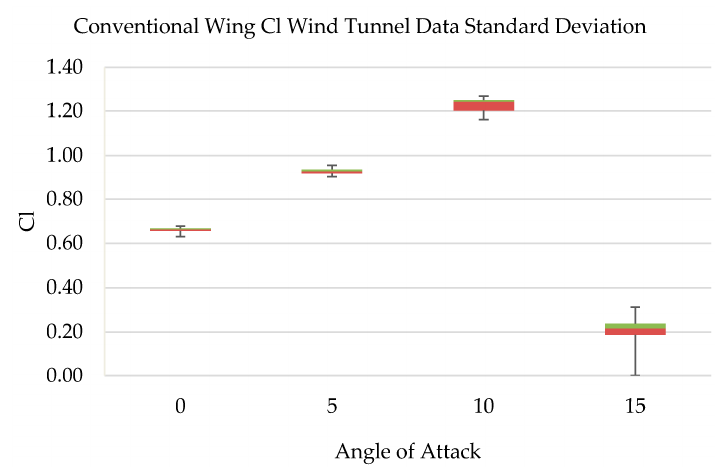
Figure 3. Conventional wing lift coefficient wind tunnel data standard deviation.